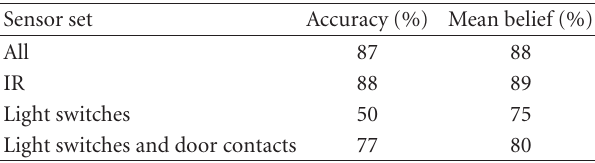
Figure 4: Variation of the accuracy depending on the value of the rejection cut on the system’s belief.